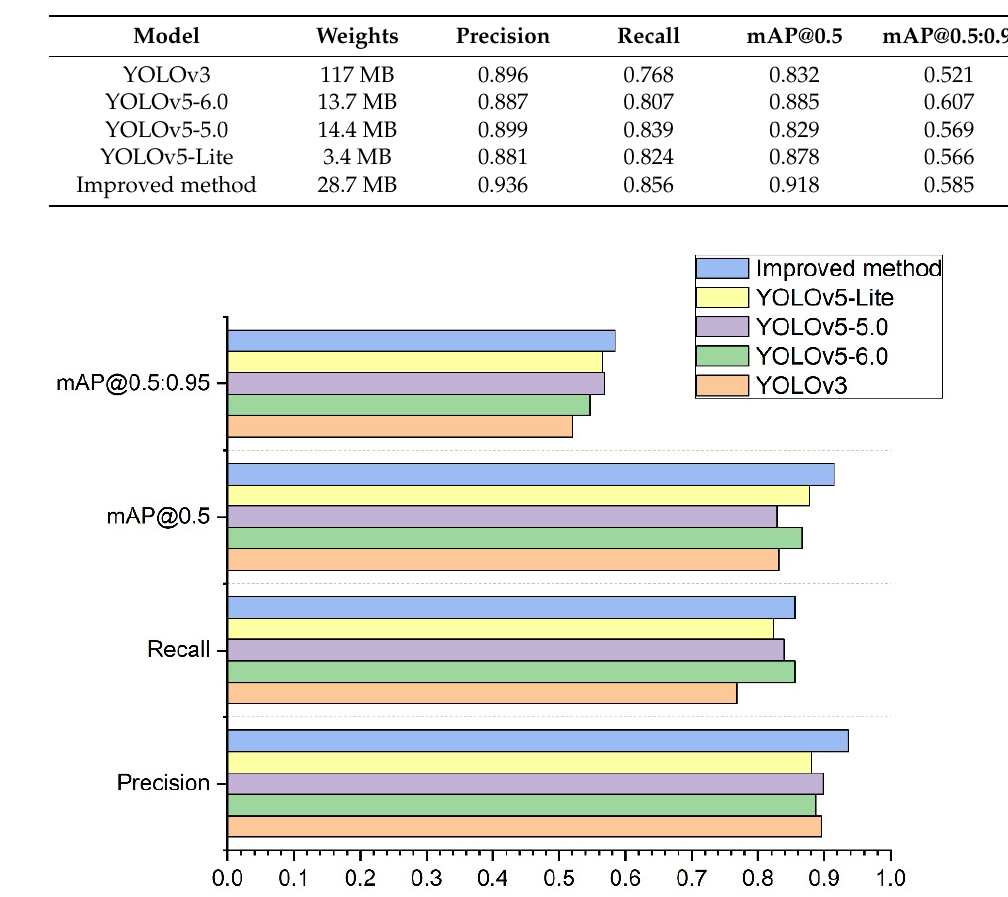
Figure 9. Comparison of performance parameters of YOLOv3, YOLOv5-6.0, YOLOv5-5.0, YOLOv5- Lite, and improved method iteration process.